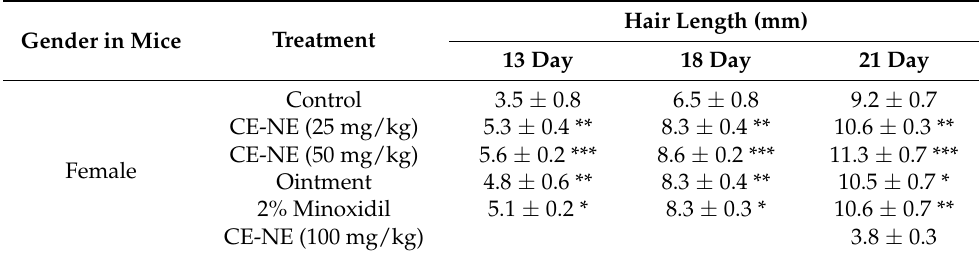
Table 4. Hair Length of Mice at 13, 18 and 21 Days.